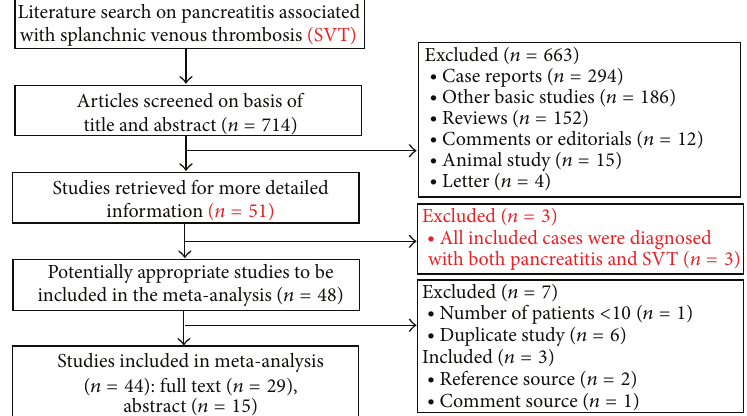
Figure 1: Flow diagram of study selection.